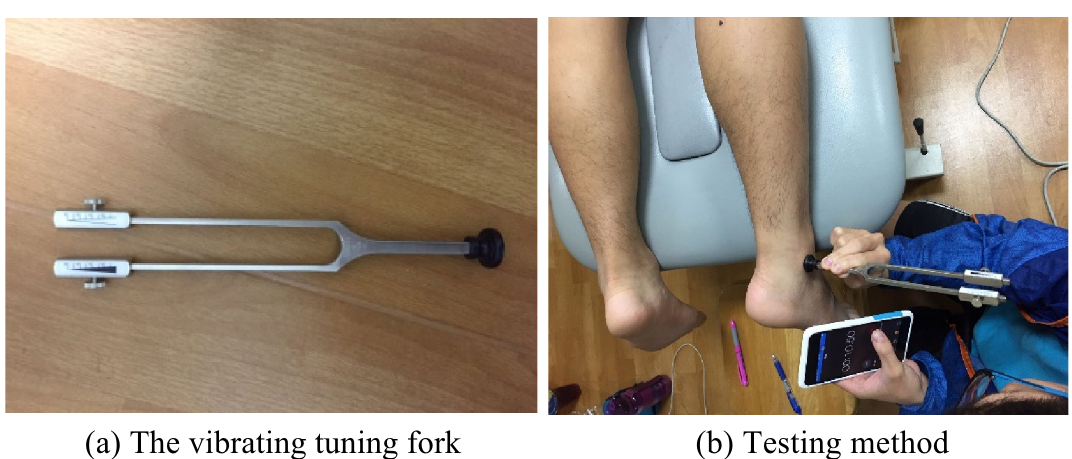
Figure 3. Device for superficial sensory test ( a ) the vibrating tuning fork; ( b ) testing method.